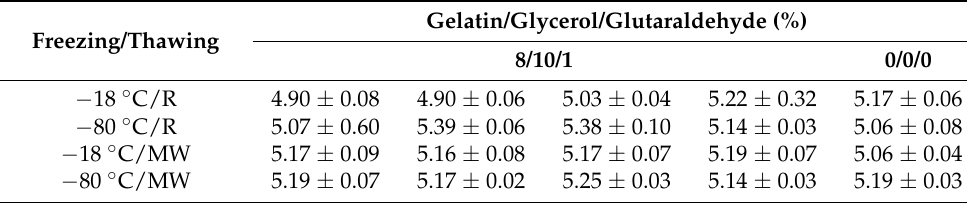
Table 4. The pH ± SD values of the meat samples with crosslinked coating and without coating depend on the method of freezing and thawing.